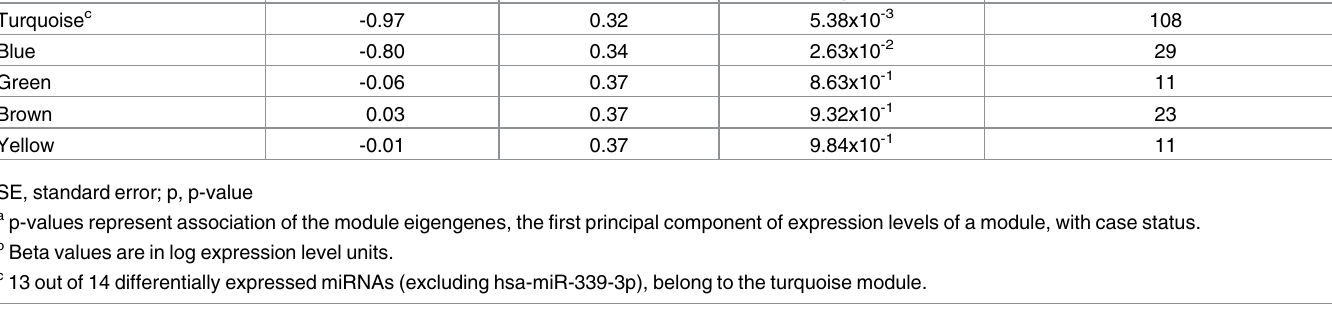
Table 3. Association between the eigengene of each miRNA co-expression module and case status. Module